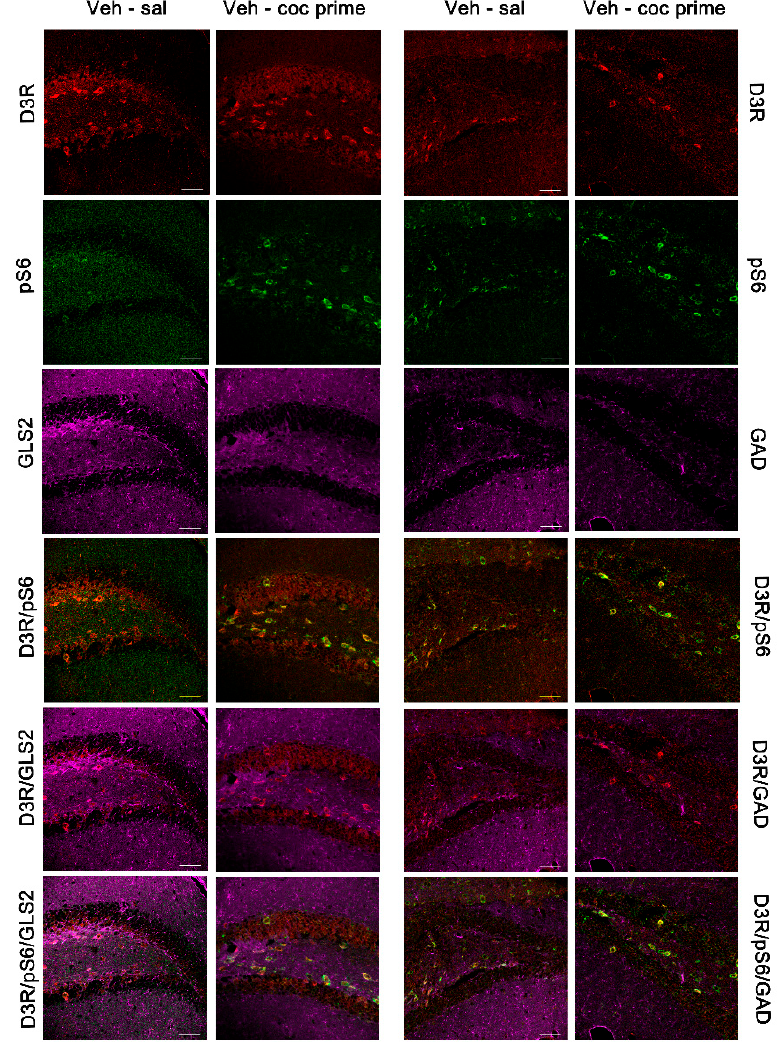
Figure 8. Representative confocal images showing the dentate gyrus coronal sections immunostained for dopamine type 3 receptor (D3DR, red), phosphorylated S6 protein (activated; green), GLS2 (magenta, glutamatergic neurons), and GAD (magenta, GABAergic neurons) from controls (veh-sal) and from mice receiving a cocaine-prime dose after 60 days of abstinence (veh-coc prime). Colocalization of D3DR/GLS2, pS6/GLS2, DRD3/pS6/GLS2, D3DR/GAD, pS6/GAD, and DRD3/pS6/GAD are also shown in the figure. Scale bars: 50 μ m.